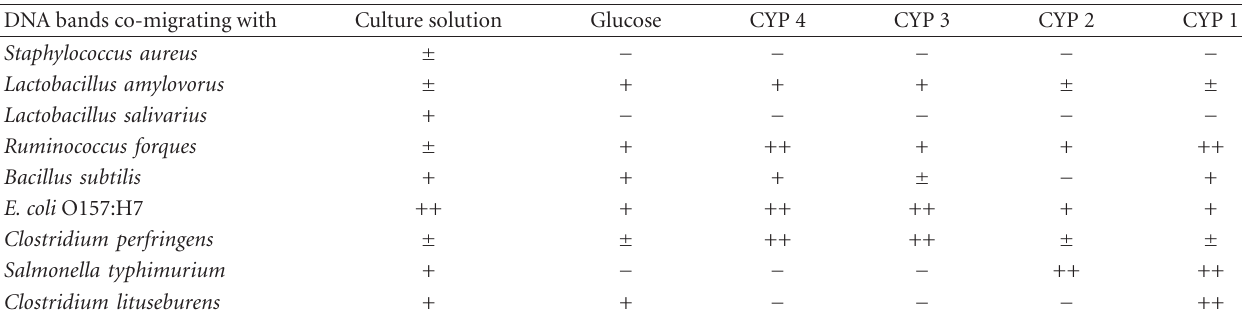
“ − ” means the bacteria is absent in this part of the intestine; “ ± ,” “+,” and “++” mean that the bacteria is present in this part of intestine and has a lower, equal or higher intensity compared to the standard strain, as also indicated in Figures 2(a) and 2(b). The four samples from each treatment group in Exp. 1 were pooled into a single